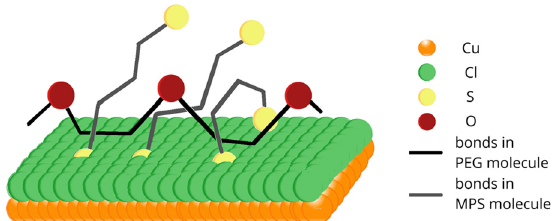
Figure 9. 3D projection of the possible molecular arrangements of MPS adsorbed units in a PEG molecular surrounding.